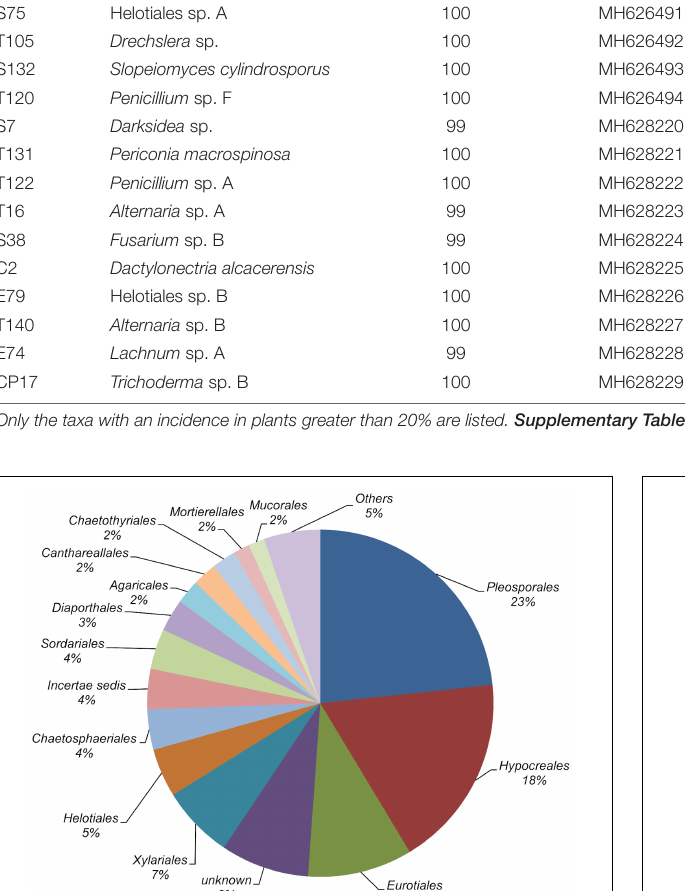
or more populations: Fusarium oxysporum (57.1%), Diaporthe